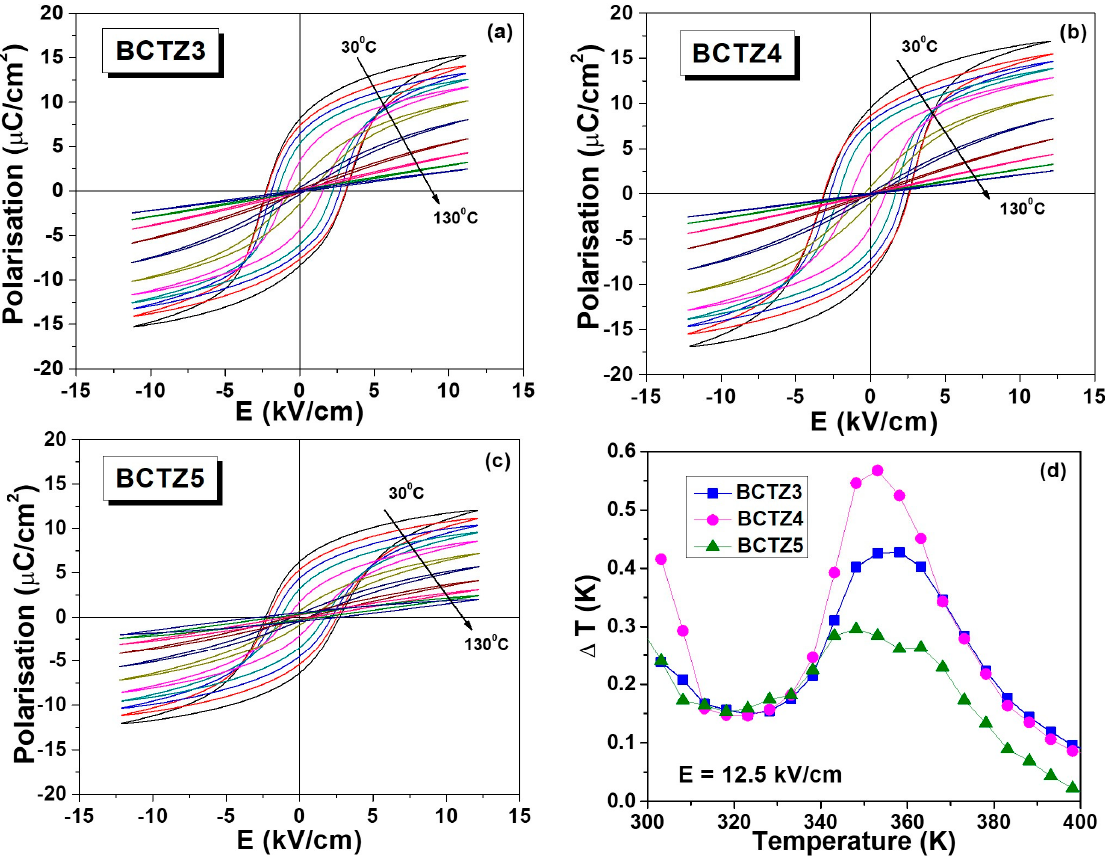
Figure 5. ( a – c ) P ( E ) loops at several selected temperatures for the BCTZ dense ceramics: ( a ) BCTZ3, ( b ) BCTZ4, ( c ) BCTZ5 and ( d ) the temperature dependence of the electrocaloric temperature change ( Δ T) under field variation Δ E = 12.5 kV/cm.